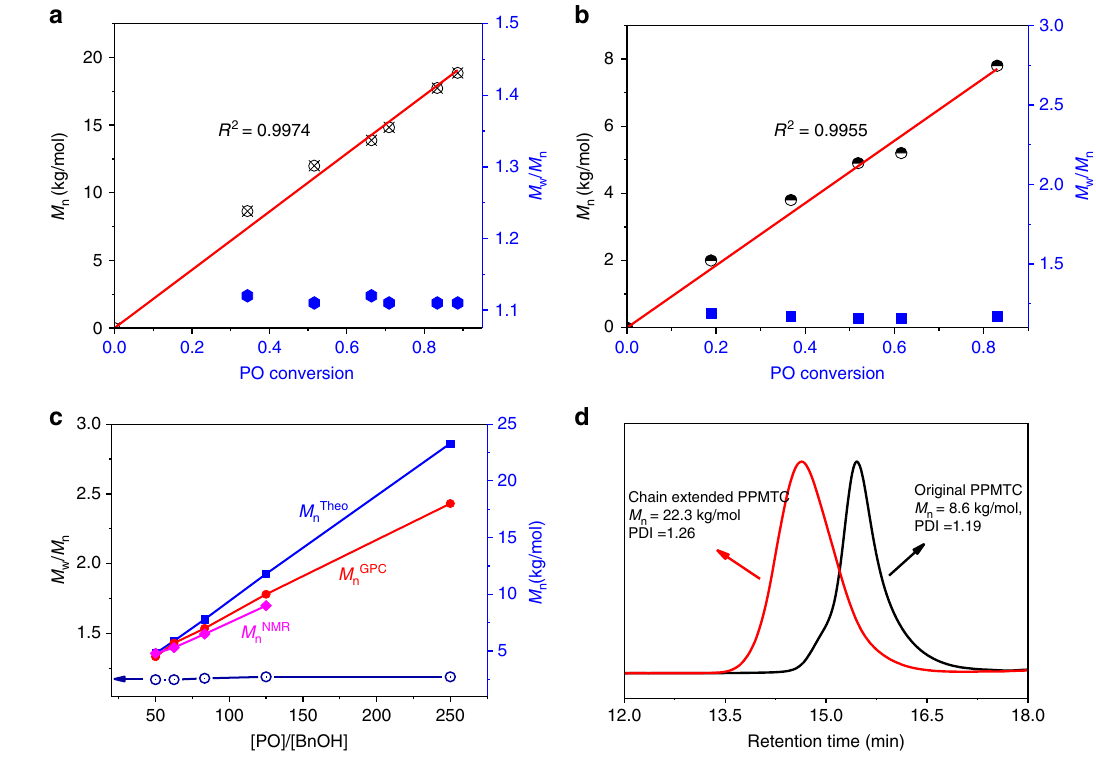
Fig. 3 Living character of Lewis pair-catalyzed COS/PO copolymerization. a Linear plots of M n of copolymer vs. PO conversion in the absence of BnOH, [DBU] = [TU-1] = 0.2 M, 25 °C; b Linear plots of M n of copolymer vs. PO conversion in the presence of BnOH ([BnOH] = 0.08 M), [DBU] = [TU-1] = 0.2 M, 25 °C; c the effect of the [PO]/[BnOH] ratio on M n s of the COS/PO copolymers [calculated value (blue line), and determined by GPC (red line) and NMR (purple line)]; d GPC traces of the PPTMCs before and after chain